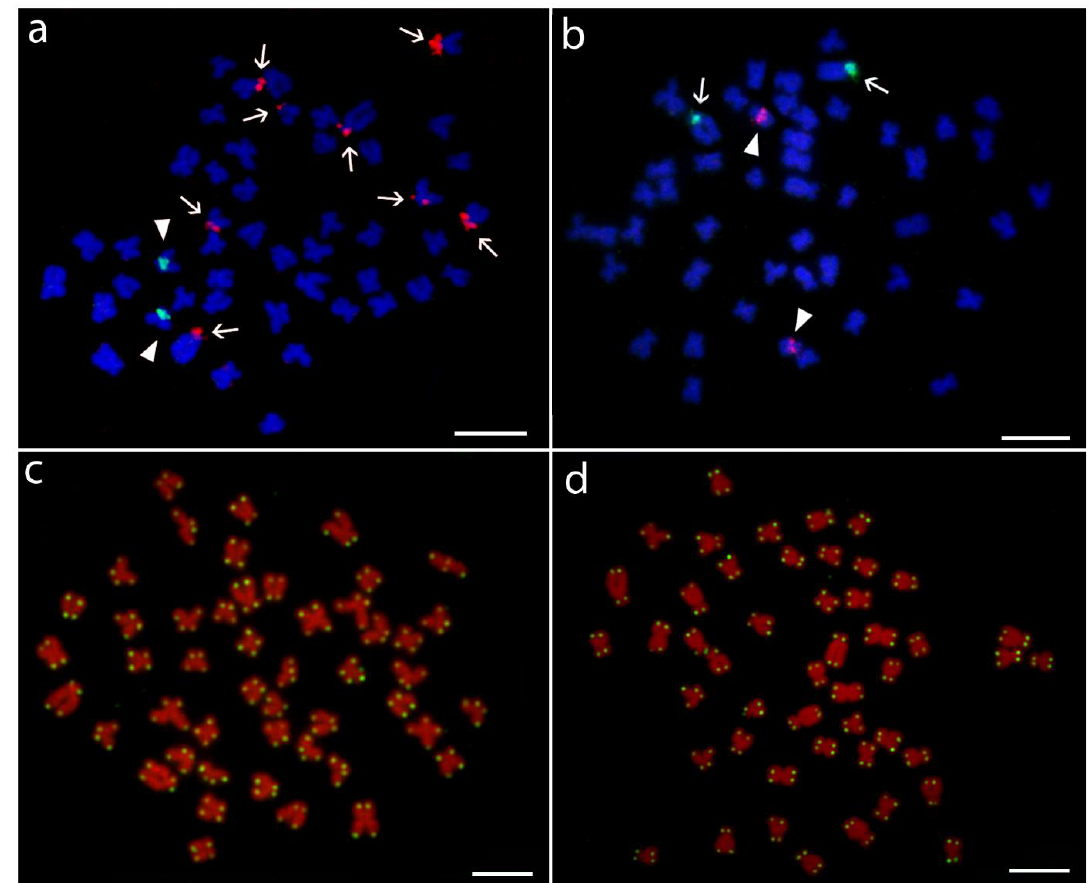
Figure 4. Mitotic metaphases of Hypophthalmichthys molitrix and H. nobilis after different cytogenetic treatments. ( a , c ) H. molitrix and individual HM4 in both methods; ( b , d ) H. nobilis , individuals HN4, and HN3, respectively. Images ( a , b ) clarify an independent location of distinct cytogenetic markers. ( a ) FISH with U1 snDNA (green, arrowheads) and 18S rDNA (red, arrows) probes. ( b ) FISH with U2 snDNA (red, arrowheads) and 5S rDNA (green, arows) probes. Chromosomes were counterstained with DAPI (blue). ( c , d ) PNA FISH with telomeric probe; for better contrast, pictures were pseudocolored in green (telomeric repeat probe) and red (DAPI). Scale bar = 10 µm.